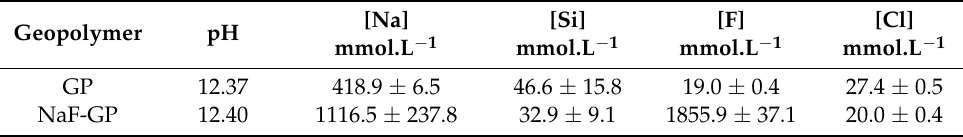
Table 2. Geopolymers, pH, and composition of the solutions used in this study.